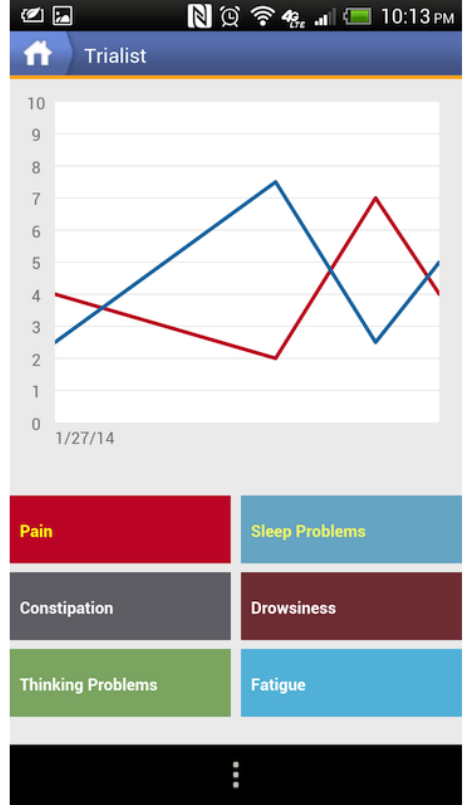
Figure 1. Example of patients’view within the